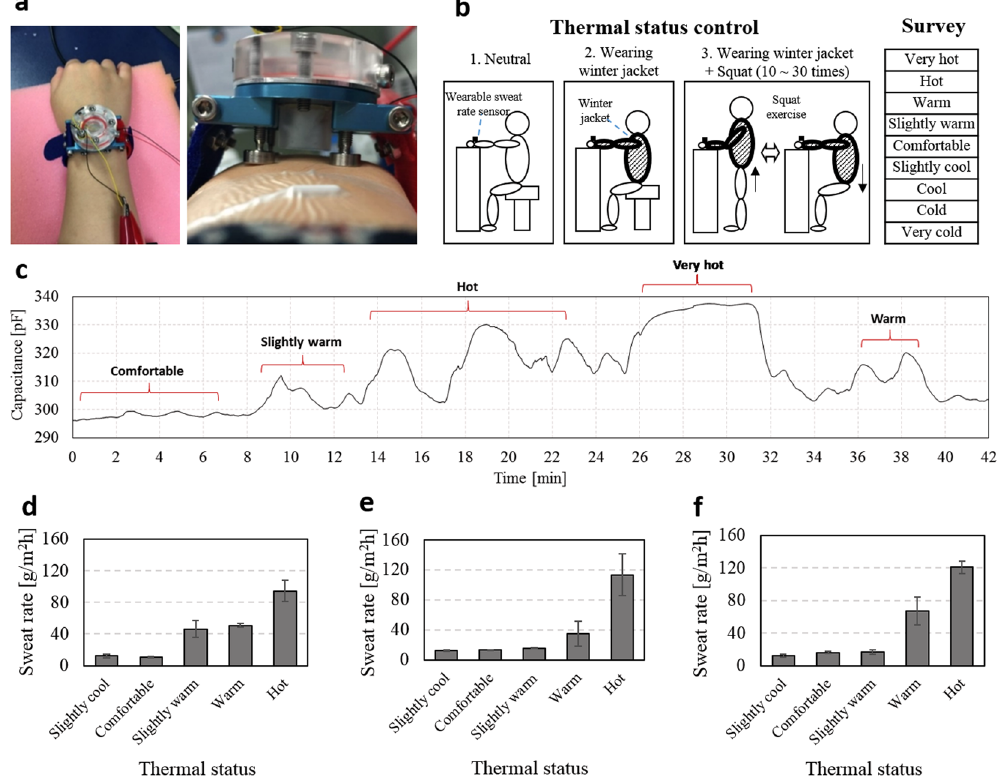
Figure 6. Human experiment: ( a ) watch-type sweat rate sensor in the wrist with 1 mm gap between the human skin and the humidity chamber; ( b ) the thermal status control using three different conditions and the survey used for thermal status evaluation; ( c ) typical profile of capacitance depending on time, where the capacitance is measured by the humidity sensor from subject 1 during the thermal status control; ( d – f ) sweat rate depending on thermal status for the three different subjects (subject